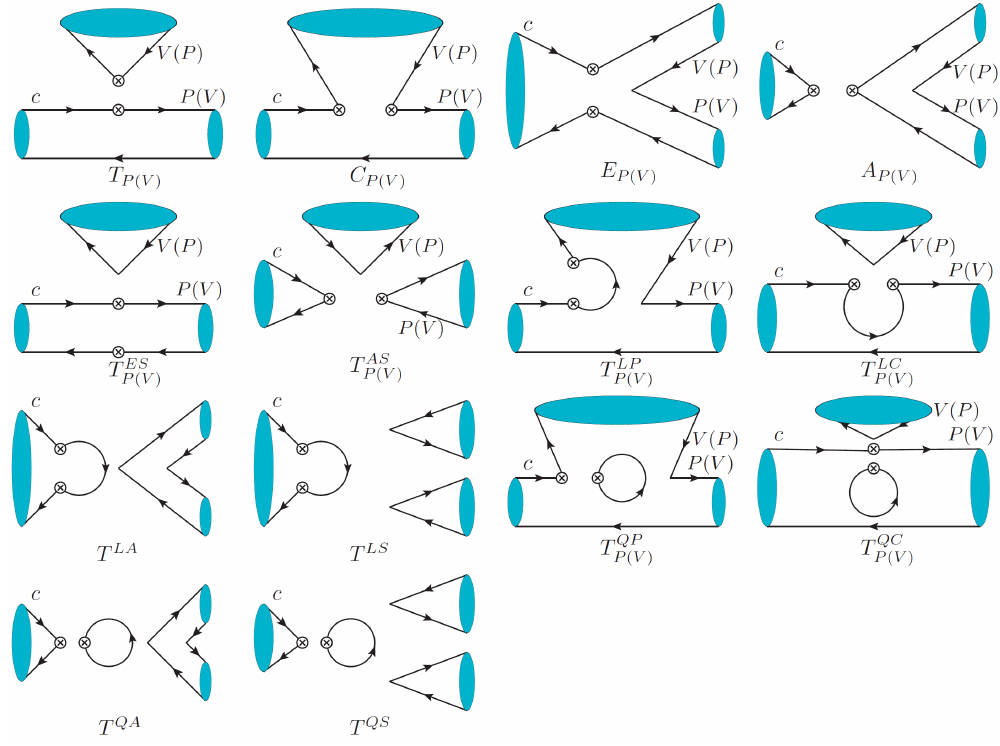
Figure 4 . Topological diagrams in the D → PV